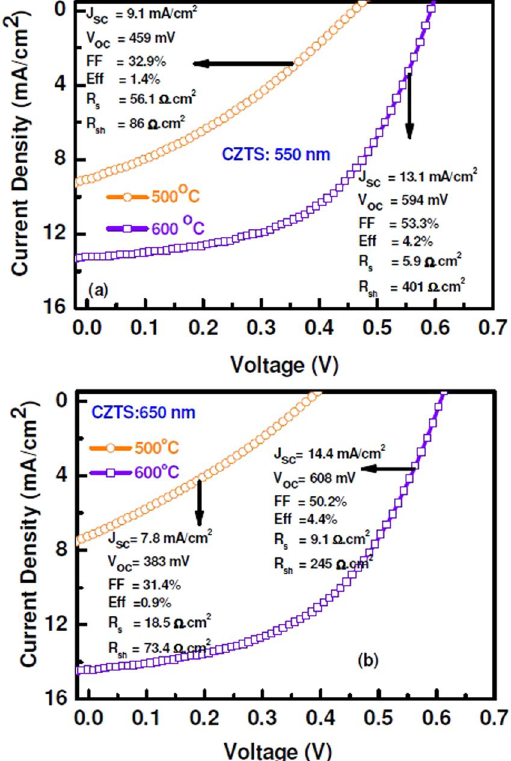
Figure 1. Current-voltage characteristics of CZTS solar cells with CZTS thickness of ( a ) 550 nm and ( b ) 650 nm. CZTS layer are sulphurized at 500 °C and 600